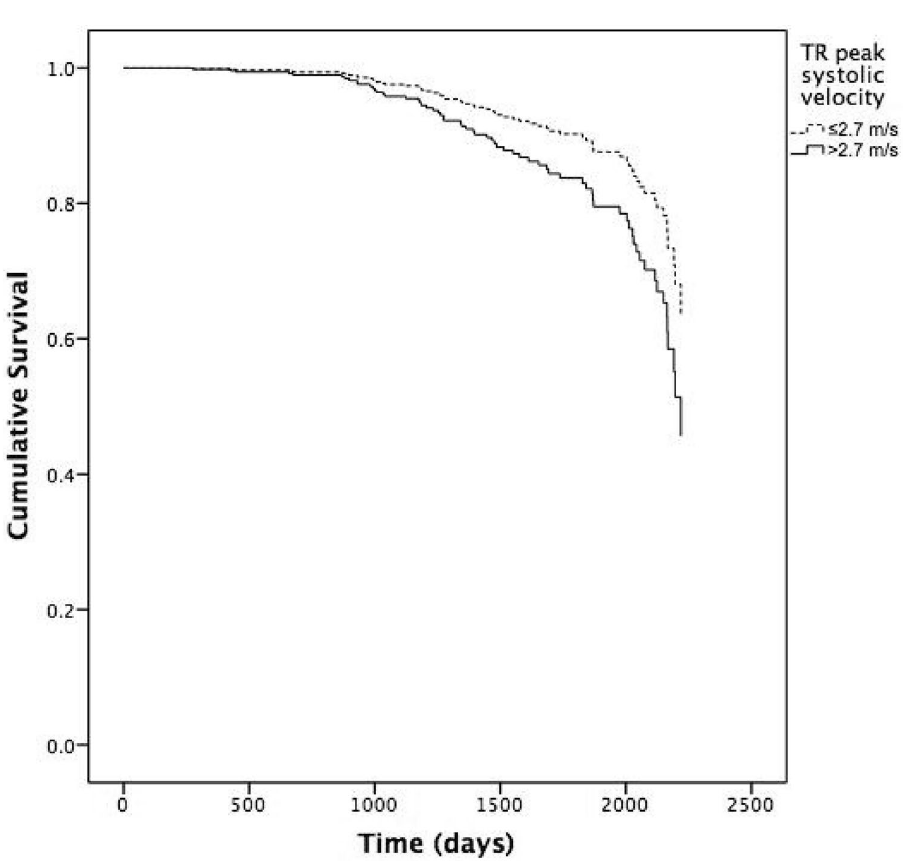
Figure 2. Survival curves and HR (adusted for age, gender, malignant etiology of pulmonary embolisn, arterial oxygen saturation, systolic blood pressure, heart rate, estimated glomerular filtration rate, troponin levels, N-terminal pro-brain natriuretic peptide levels and left ventricular ejejction fraction). Abbreviations: TR— tricuspid